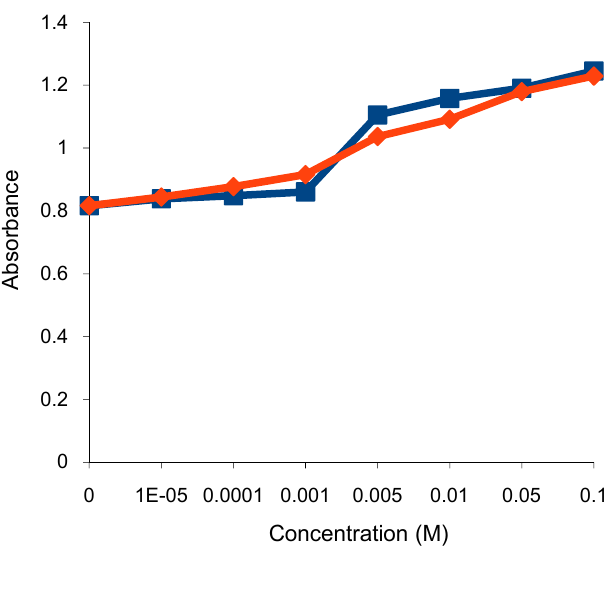
Figure 10. Turbidity absorbance of sensing element vs. concentration of Hg 2+ in tap ( ) and distilled water (